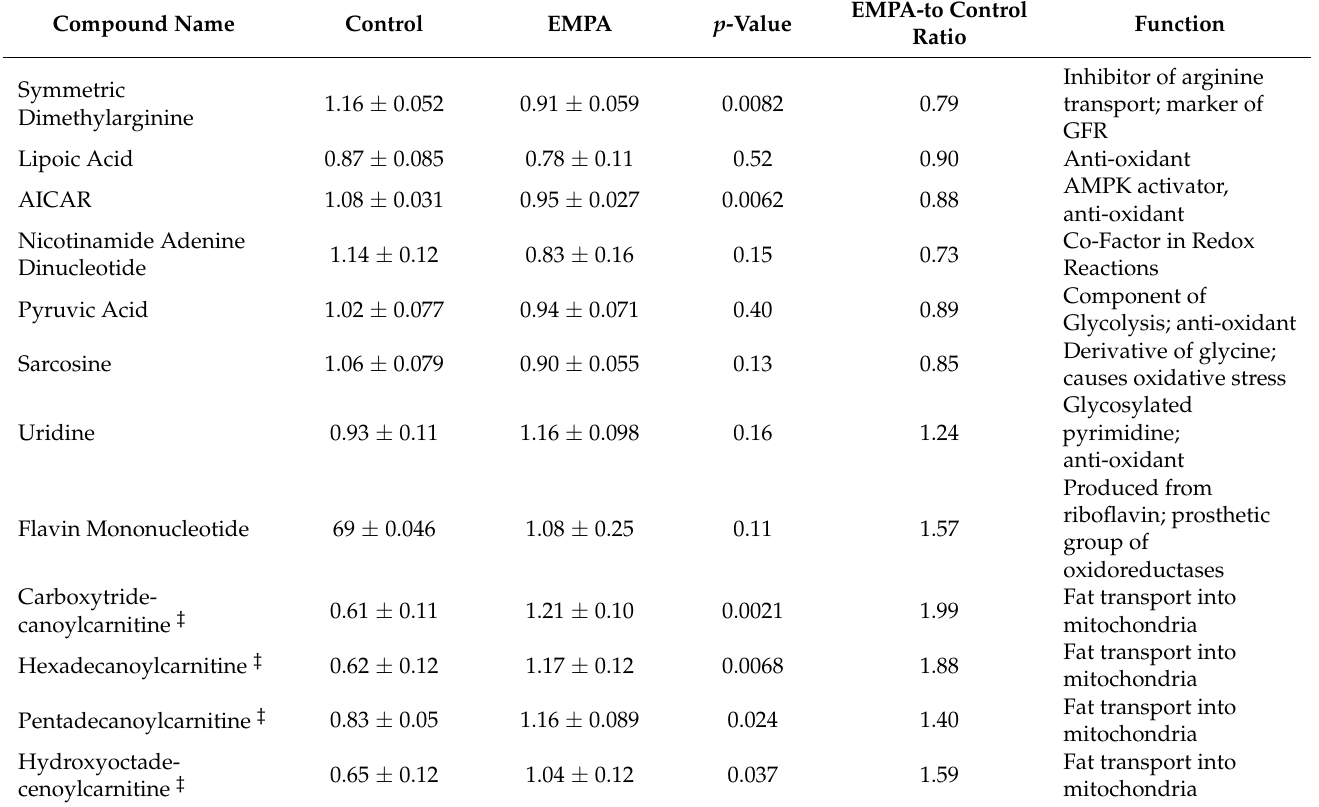
Table 3. Oxidative-Stress-Related Metabolic and Lipidomic Species †